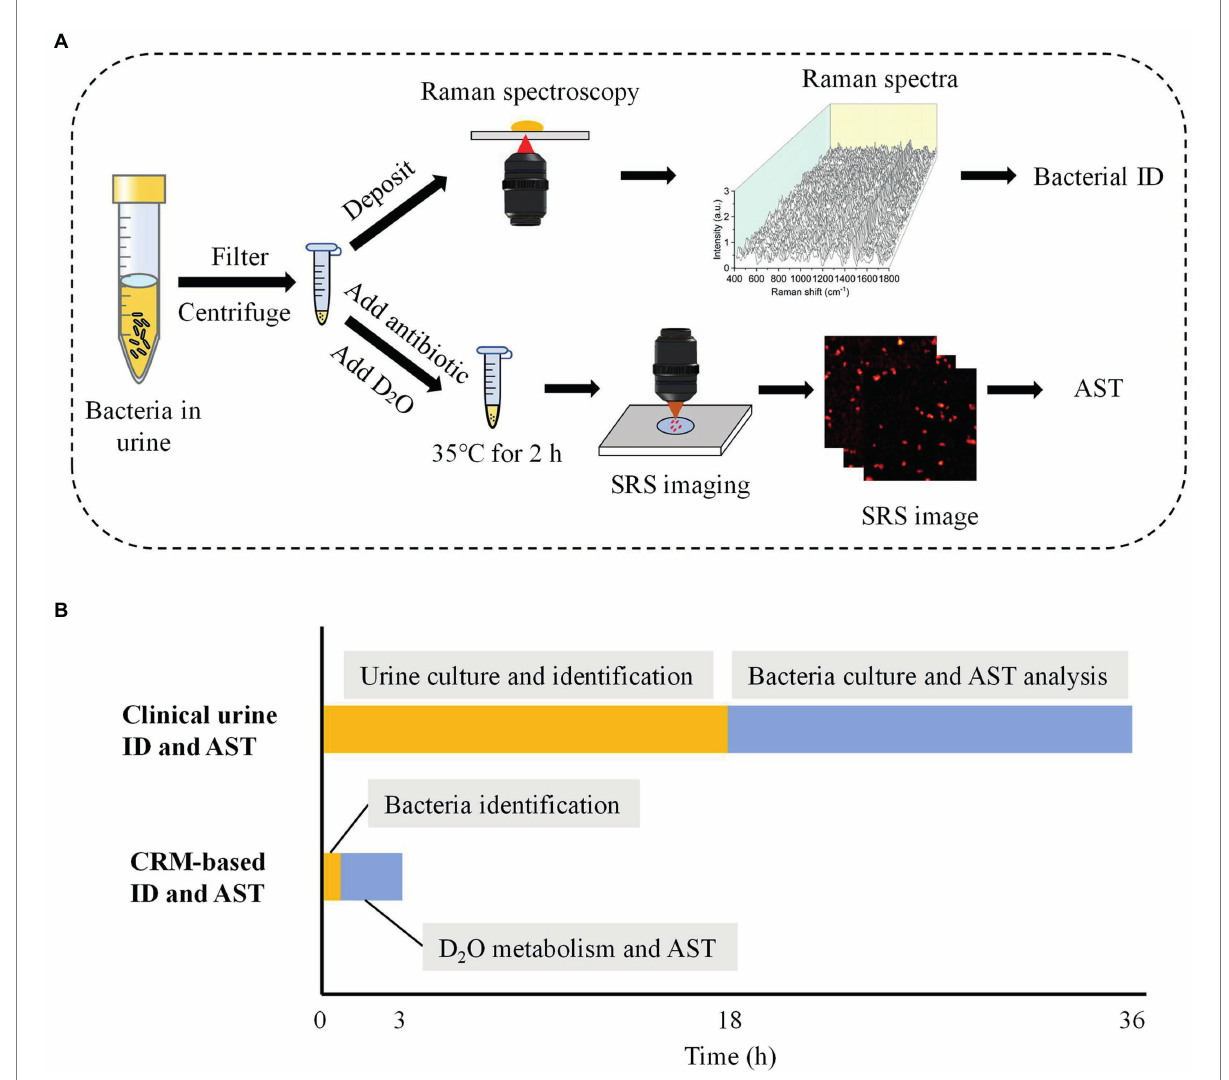
FIGURE 2 Workflow of the CRM for rapid identification and AST in urine. (A) The flow chart of bacterial identification and AST for urine samples. (B) Turnaround time required for the conventional and CRM-based bacterial identification and AST for urine samples. The time estimation was based on optimal conditions. ID,